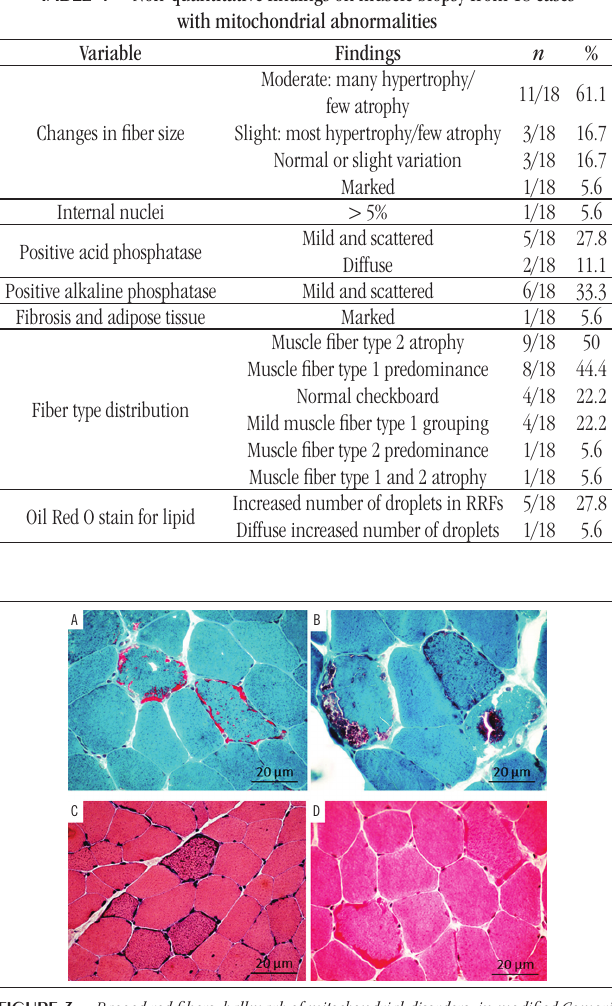
figurE 3 − Ragged red fibers, hallmark of mitochondrial disorders, in modified Gomori trichrome (A and B) and HE (C and D). Note the red subsarcolemmal mitochondrial accumulation (A, B, and C) and the intermyofibrillar disruption (“ ragged ”) in B HE: hematoxylin and eosin.